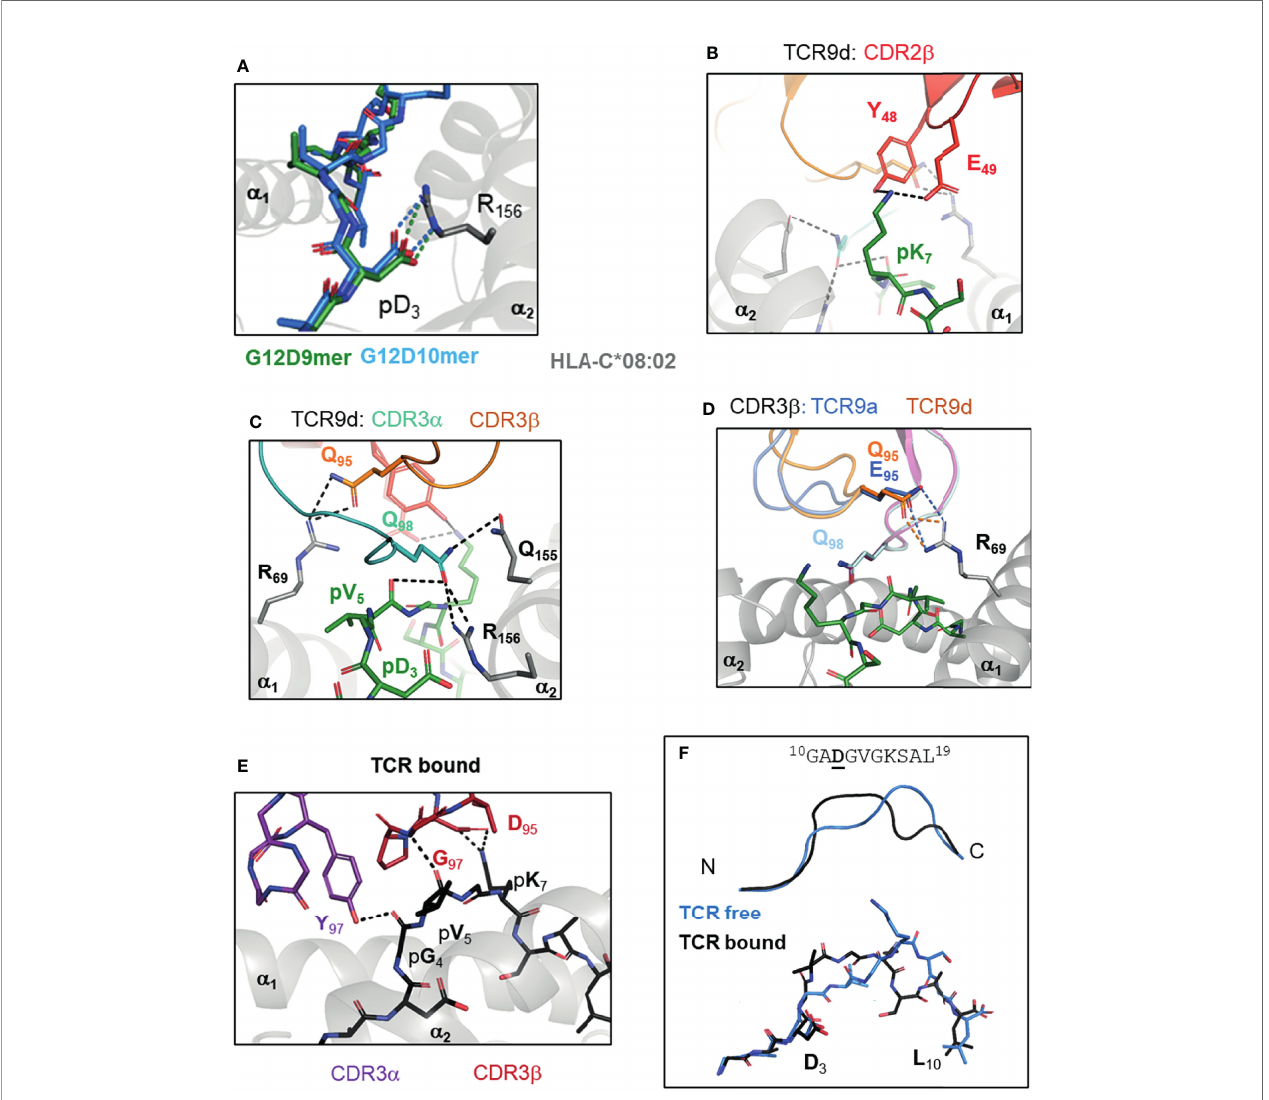
FIGURE 3 | TCR recognition of group 2 neoantigens, novel ‘ non-self ’ epitopes generated by the KRAS-G12D mutation. (A) KRAS-G12D neoantigens G12D-9mer (GA D GVGKSA) and G12D-10mer (GA D GVGKSAL) form a salt bridge mutant p3 Asp and HLA-C Arg 156 on a 2 helix of HLA-C*08:02 (PDB entry 6ULI, 6ULK). (B-D) TCR recognition of G12D-9mer by TCR9a and TCR9d. (B) Shared CDR2 b contacts with p7 Lys (6ULN). (C) Shared CDR3 a contacts with p5 Val and Gln 155, Arg 156 of HLA-C*08:02 (6ULN). (D) Position 95 CDR3b contact with Arg 69 of HLA-C*08:02 modi fi es TCR9 binding strength (6ULN,6ULR). (E, F) TCR10 recognition of G12D- 10mer. (E) TCR10 CDR3 a and CDR3 b contacts with G12D-10mer (6UON). (F) G12D-10mer conformation in TCR free and TCR10 bound forms